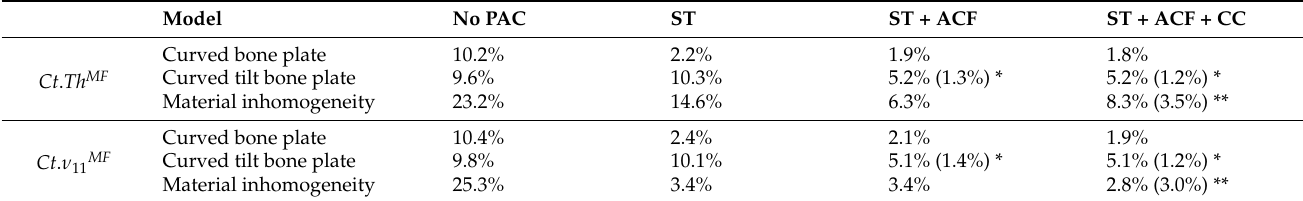
Table 4. Accuracy of Ct . Th MF and Ct . ν 11 MF after each PAC